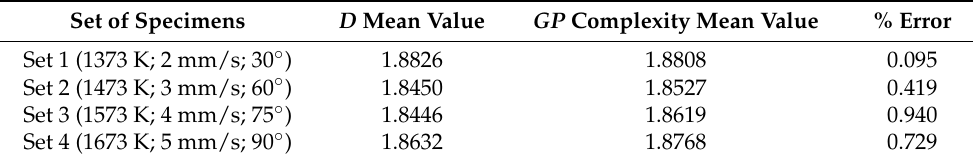
Table 5. Comparison between calculated and predicted values of RLH specimens’ complexity. Set of Specimens D Mean Value GP Complexity Mean Value % Error Set 1 (1373 K; 2 mm/s; 30 ◦ ) 1.8826 1.8808 0.095 Set 2 (1473 K; 3 mm/s; 60 ◦ ) 1.8450 1.8527 0.419 Set 3 (1573 K; 4 mm/s; 75 ◦ ) 1.8446 1.8619 0.940 Set 4 (1673 K; 5 mm/s; 90 ◦ ) 1.8632 1.8768